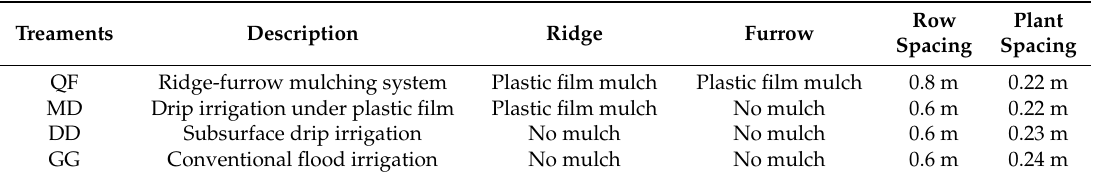
Table 1. The specific trial layout in maize growing seasons.